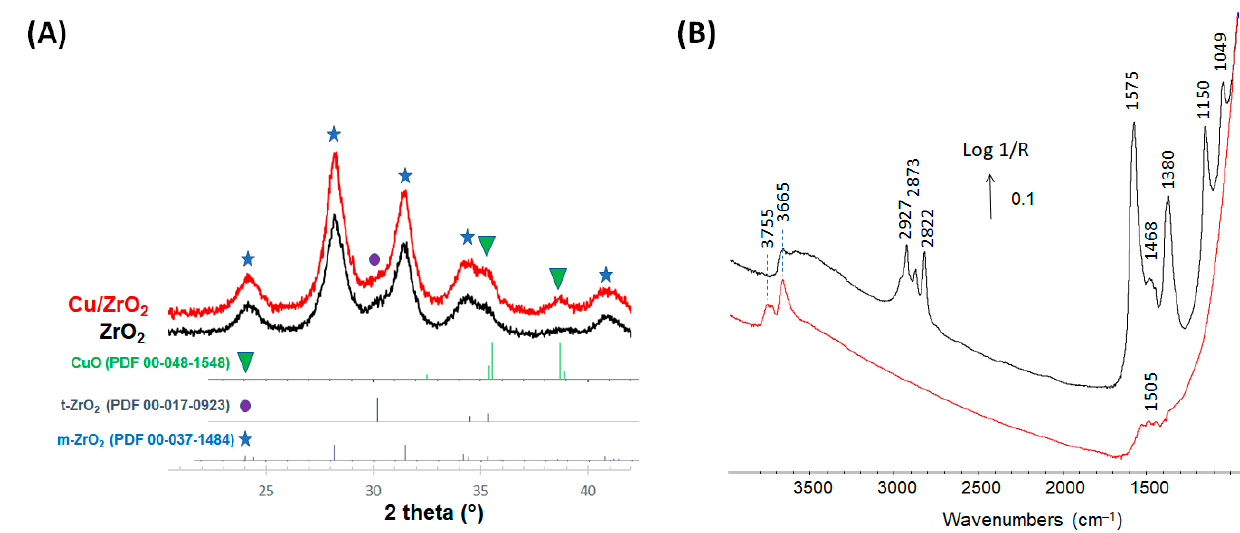
Figure 2. ( A ) XRD patterns of the zirconia support and the calcined zirconia ‐ supported Cu. The main peaks of PDF reference files are given underneath. ( B ) In situ DRIFTS spectrum at 220 °C of the ZrO 2 ‐ supported Cu sample under 80% H 2 /He (Red) after reduction at 350 °C and (Black) after reaction and then exposed to H 2 ‐ only feed for 60 min at 220 °C.